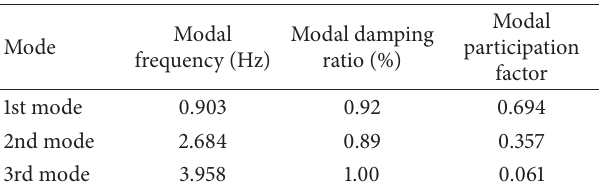
Table 10: Estimation results of dynamic characteristics for Case 1